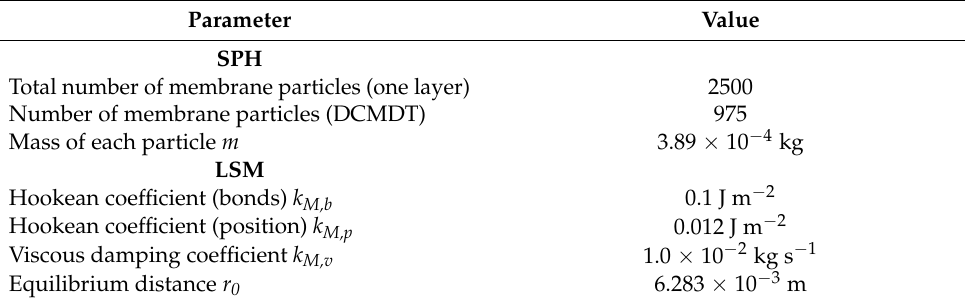
Table 2. Model parameter of the